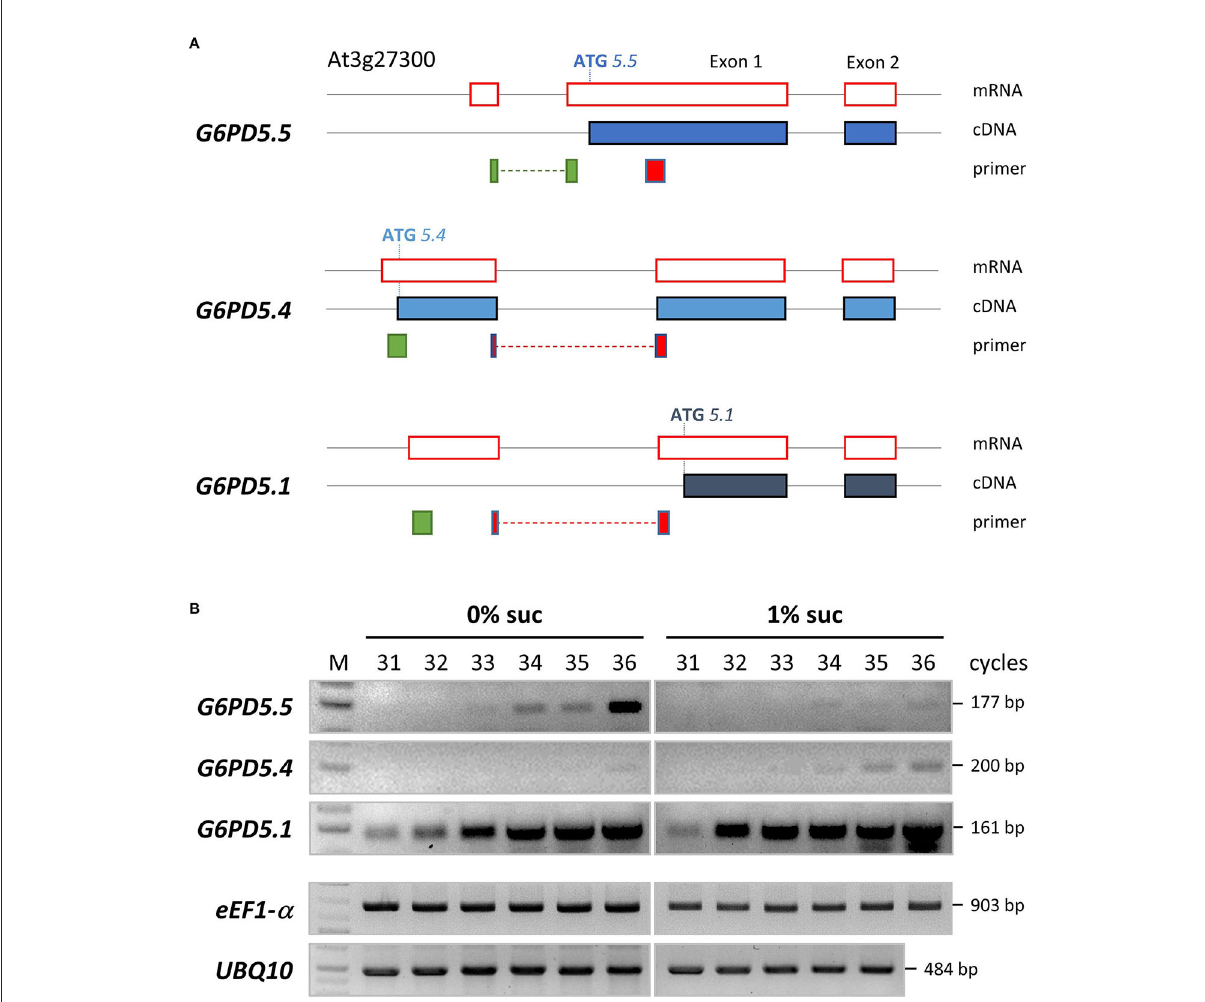
FIGURE1 Alternative splice variants and semi-quantitative RT-PCR analyses of G6PD5 . (A) To scale representation of the G6PD5 locus (At3g27300) with 5 ′ UTR until exon 2. Black lines, genomic DNA; red boxes, mRNA parts upon splicing; filled blue boxes, resulting coding sequences (cDNA). Note that alternative splicing leads to different ATG start positions. Primer binding sites are depicted underneath (green, sense; red, antisense primers, with intron-spanning regions as dashed lines). According to an RNA-seq tool (Arabidopsis.org, ARAPORT11/splice junctions and/transcript assembly), G6PD5.1 and G6PD5.4 are the most abundant splice variants, whereas G6PD5.5 is not present in all tissues, but amounts to about 10% of the other two (e.g., in light-grown seedlings, 476 counts for G6PD5.4 and G6PD5.1 compared to 52 for G6PD5.5 ). (B) Semi-quantitative RT-PCR analyses of RNA isolated from seedlings (4-leaf stage) grown under a short-day regime in the absence (0% suc) or presence of sucrose (1% suc) on agar plates (0.8%, 0.5MS, pH 5.7). Note that G6PD5.5 is more abundant under autotrophic conditions (0% suc), whereas G6PD5.4 (and by trend also G6PD5.1 ) is more abundant under the physiological sink condition (1% suc). Two house-keeping genes, e EF1- α (eukaryotic translation elongation factor, At5g60390) and UBQ10 (polyubiquitin10, At4g05320), were included as reference. M, GeneRuler 1kb Plus